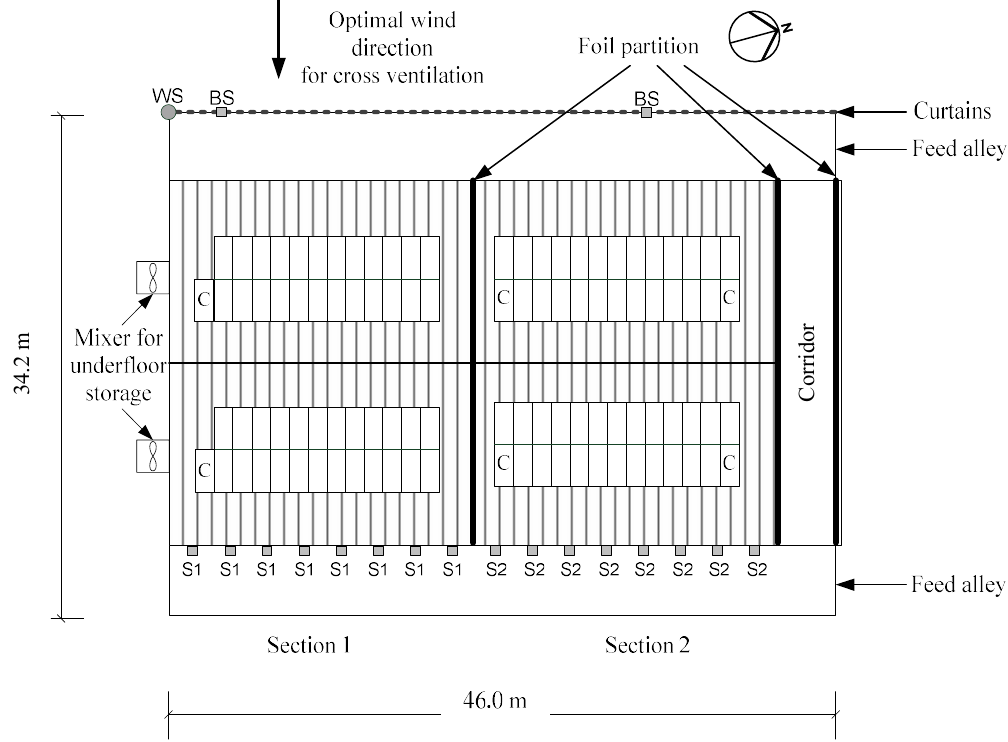
Figure 1. Construction plan of the barn and the slurry storage systems. Sections 1 and 2 have slatted floors. The level of slurry homogenisation varied among Sections 1 and 2. WS: weather station, located on the rooftop of the western eave; BS: background sampling points; S1–S2: sampling points (Sections 1 and 2) of the gases, described in the text; C: concentrate stations; small rectangles: slatted floor; wide rectangles: bedding area.